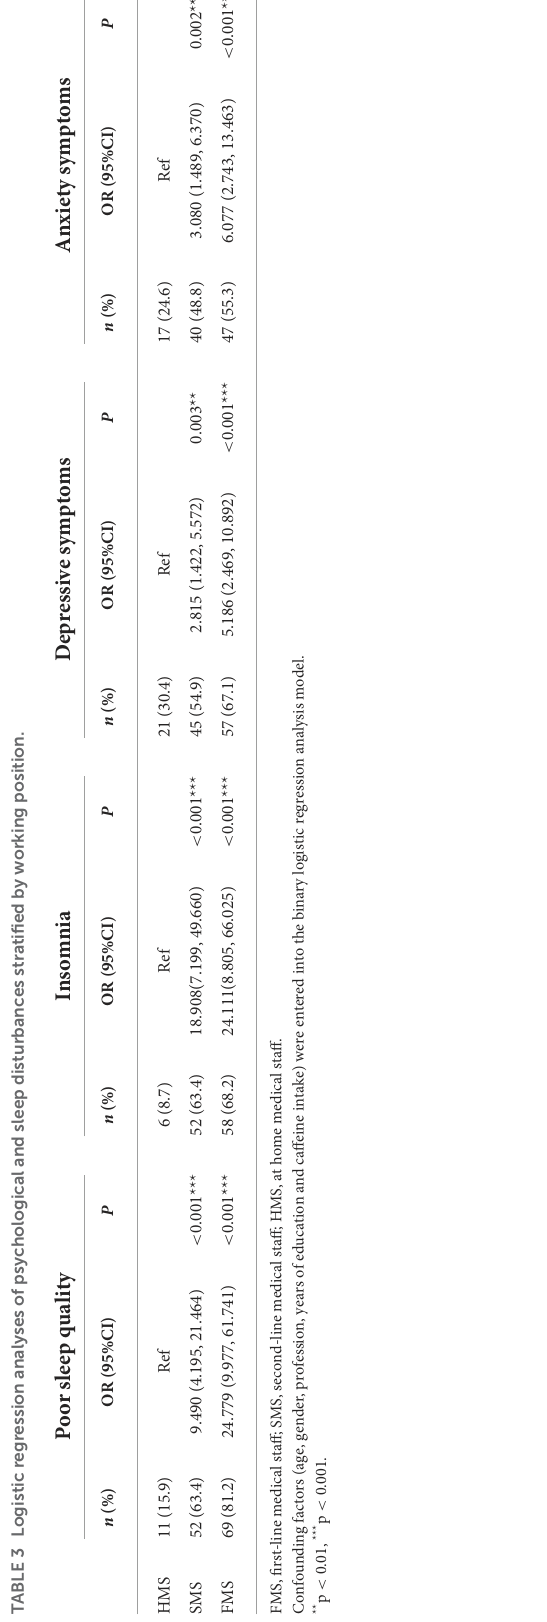
TABLE 4 Correlations among the four